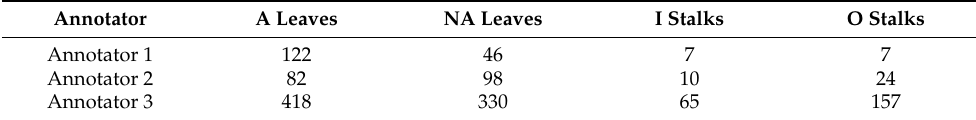
Table 4. Class instances annotated by the three annotators for stover overlengths.